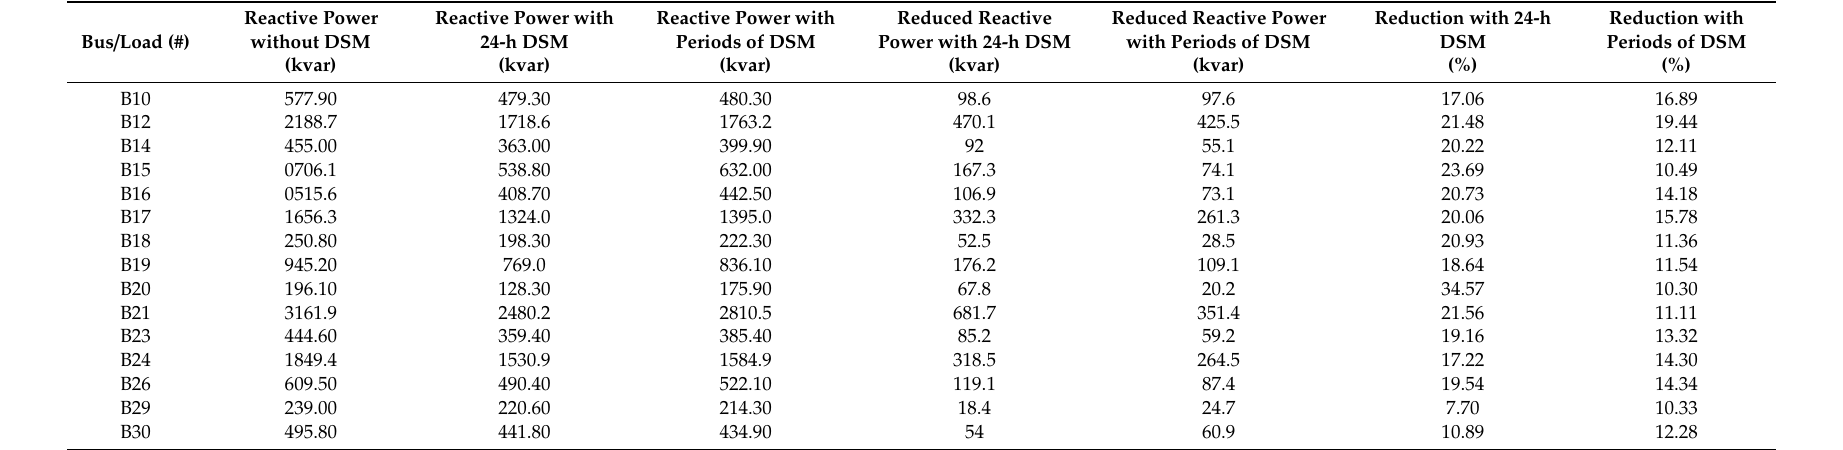
Table 9. Case VII: Reactive power with / without